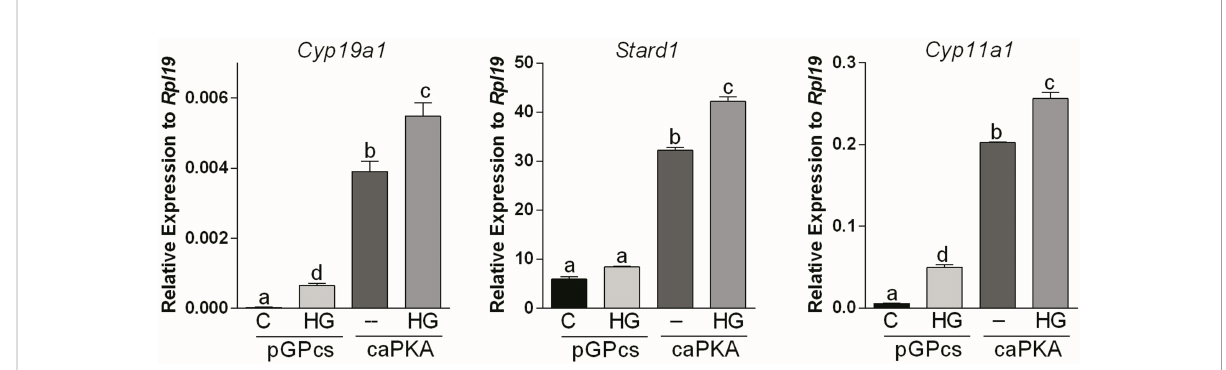
FIGURE 4 SIK inhibition enhances constitutively active PKA stimulation of gene expression. Rat GCs were infected 2 h after plating with lentivirus carrying an empty plasmid (pGPcs) or caPKA. 24 h later, cells were treated with vehicle or HG (0.5 µM). Cyp19a1 , Stard1 , and Cyp11a1 mRNA levels were